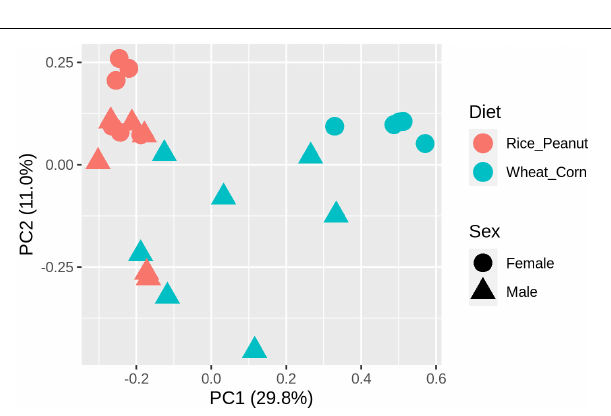
FIGURE 4 | The principal component analysis (PCA) diagram using Bray–Curtis distances on the normalized abundance of OTUs between female and male Great Bustards with different